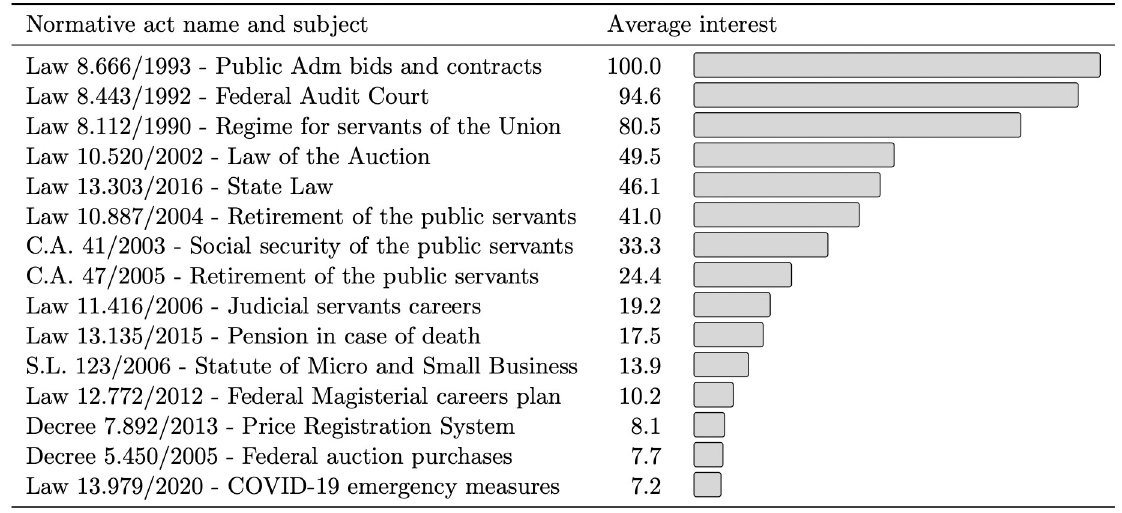
Fig 10. Average interest of normative acts on